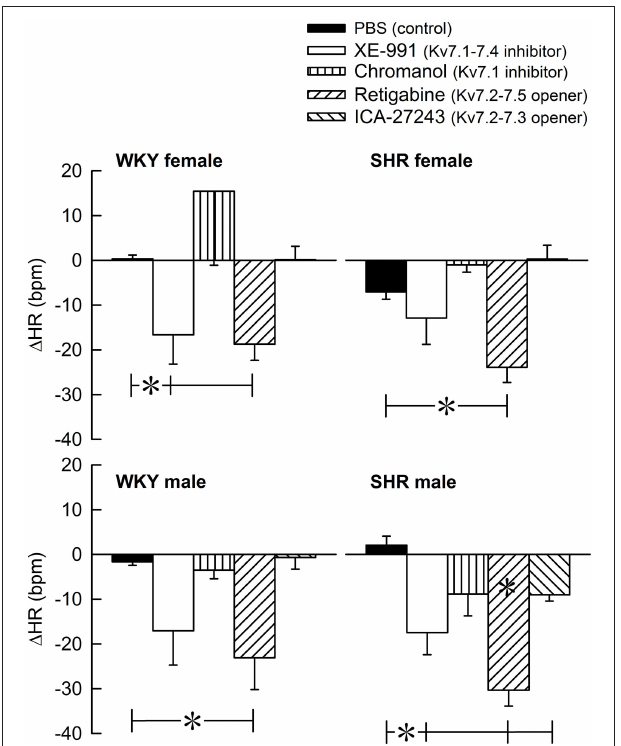
FIGURE 3 | The acute HR-response to Kv7 inhibitors/openers. The rats were pre-treated with PBS (controls) or Kv7 inhibitor or opener, as indicated by the symbol legends. The change in HR compared to baseline was recorded at the time of the maximum change in TPR ( Figure 2 ). Comparisons were made between corresponding PBS-control and experimental groups, and for corresponding experimental groups across sex (none detected) or strain (*within column). Analyses were done by one-way ANOVA, followed by Student’s two-sample t -tests or Kruskal–Wallis test. * P ≤